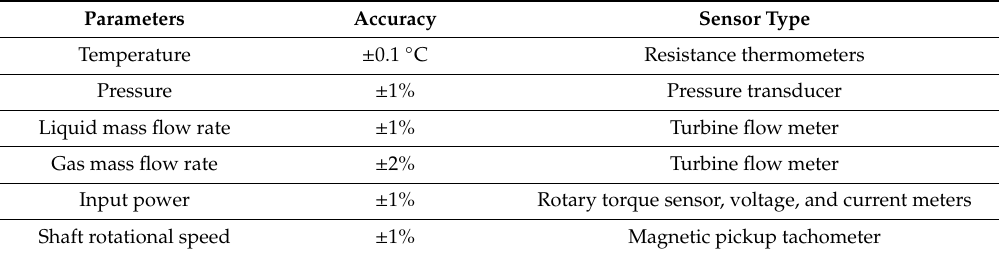
Table 2. Measurement accuracy.